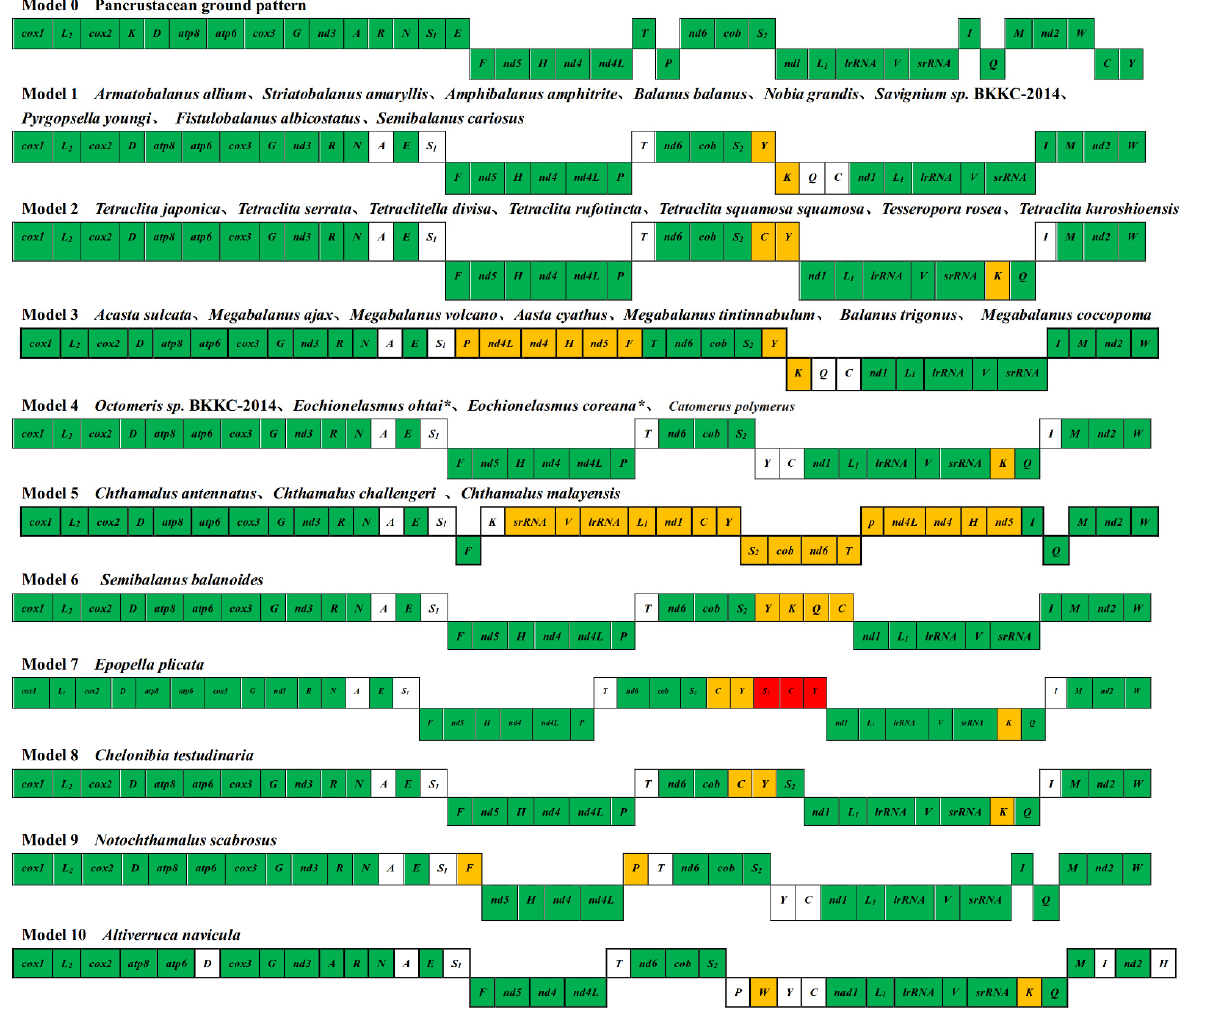
Figure 3. Comparison of mitochondrial gene arrangements in the Balanomorpha suborder. Shadow boxes represent conserved blocks; orange and green indicate blocks with or without inversion, respectively; white depicts translocated blocks; and encoded in heavy and light chains, genes are placed on the top and bottom line, respectively.